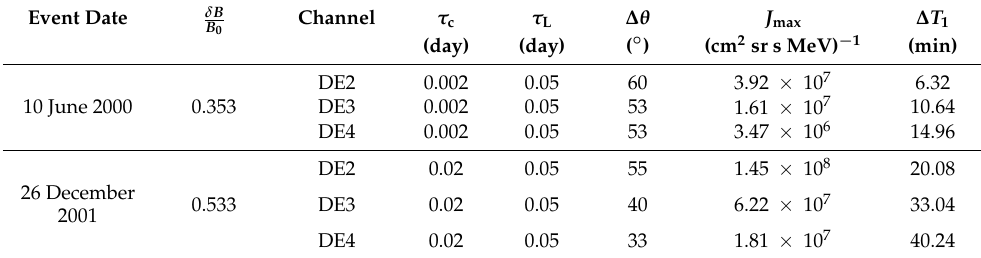
Table 3. Best fit parameters for the